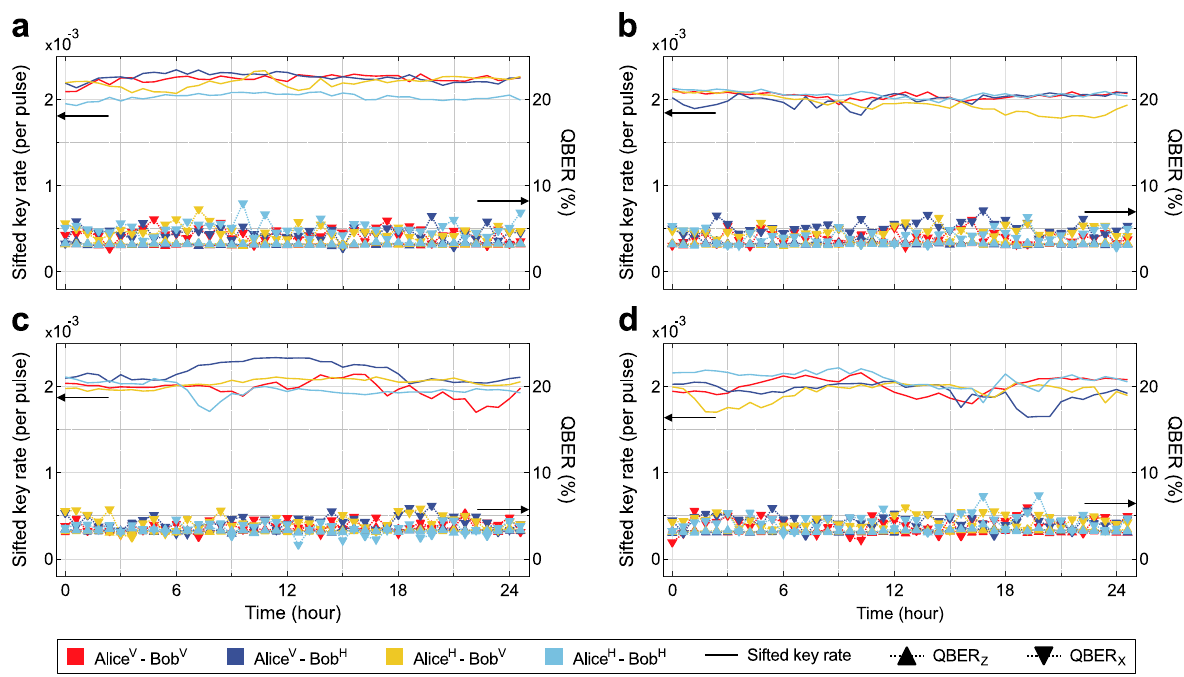
Fig. 8 Sifted key rate and quantum bit error rates (QBERs) of 16 network connections for a day. a Result of ITU channel 31. b Result of ITU channel 32. c Result of ITU channel 33. d Result of ITU channel 34. The results are drawn in different colors depending on the network connections of Alice V – Bob V , Alice V – Bob H , Alice H – Bob V , and Alice H – Bob H . Sifted key rate is indicated by a solid line and QBERs are represented by dot lines with upward- or downward-pointing triangles,